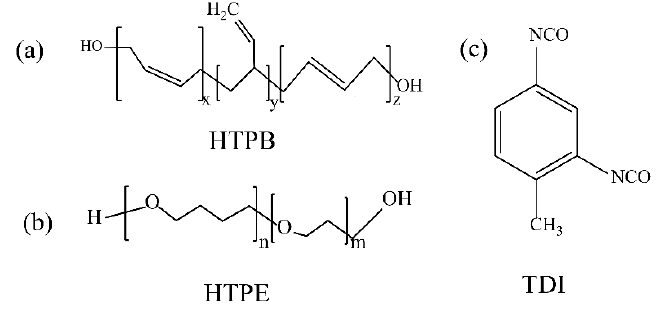
Figure 1. Structural formulae of HTPB, HTPE and TDI.